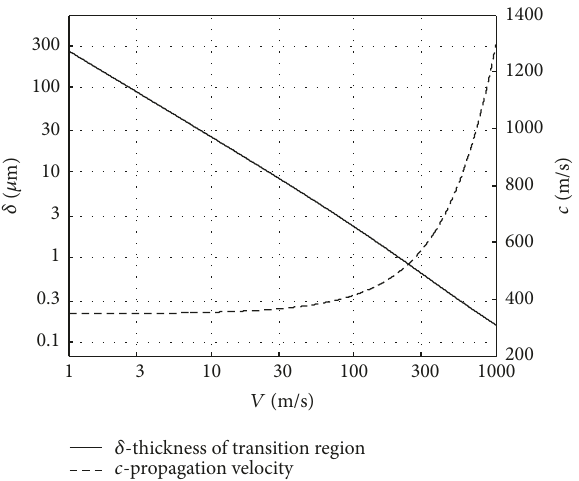
Figure 8: Relationship of entropy generation and temperature across compressing wave for different